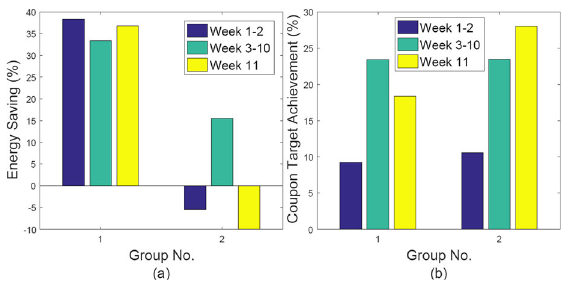
Fig. 9 Behavior comparisons between subjects in Subgroup S1 and S2. a Average energy saving at 1 – 7 pm. b Coupon target achievement percentage